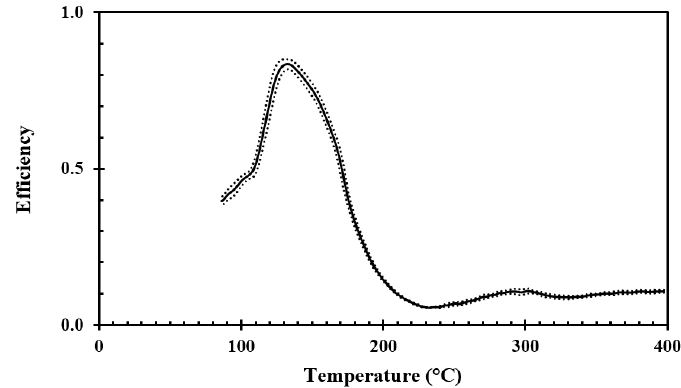
Figure 13. Average cooling efficiency for water droplets impinging onto the aluminum disc with a surface roughness of Ra 3 as a function of temperature ( black ). The dotted lines represent ± one standard deviation, respectively.